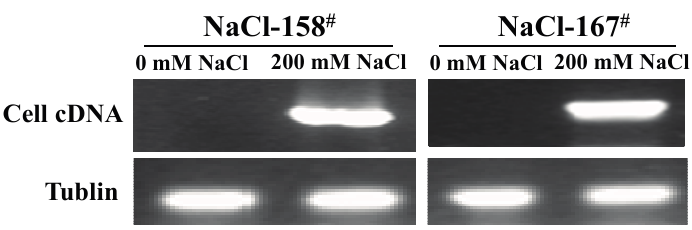
Figure 2. Expression of NaCl-158 # and NaCl-167 # in P. tenuiflora culture cells untreated and treated with 200 mM NaCl for 12 h by RT-PCR